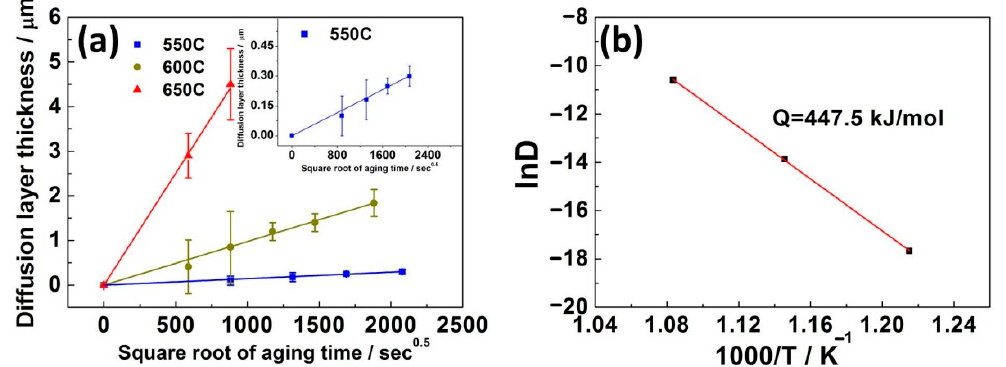
Figure 7. ( a ) Variation of the diffusion layer thickness of the pretreated joints with the square root of aging time between 550 °C and 650 °C. The inset is the enlargement of the result at 550 °C. ( b ) Variation of ln D with 1000/ T between 550 °C and 650 °C. Table 1. Fitting results of the growth rate and the relationship between diffusion layer thickness and aging time